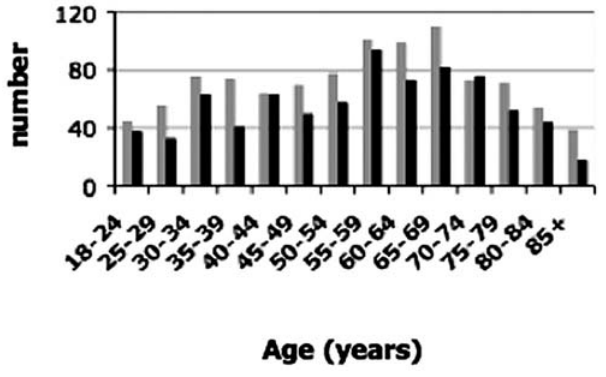
Figure 3. Age and sex distribution of the participants to the study: 5 years periods were considered. In black are the males, in grey are the females.